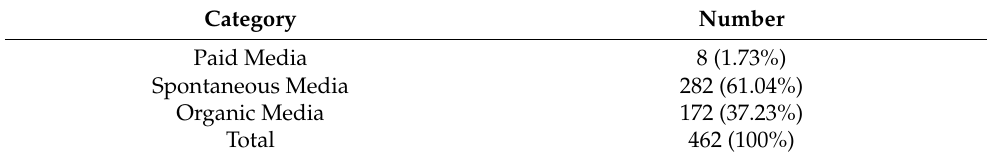
Table 5. Types of